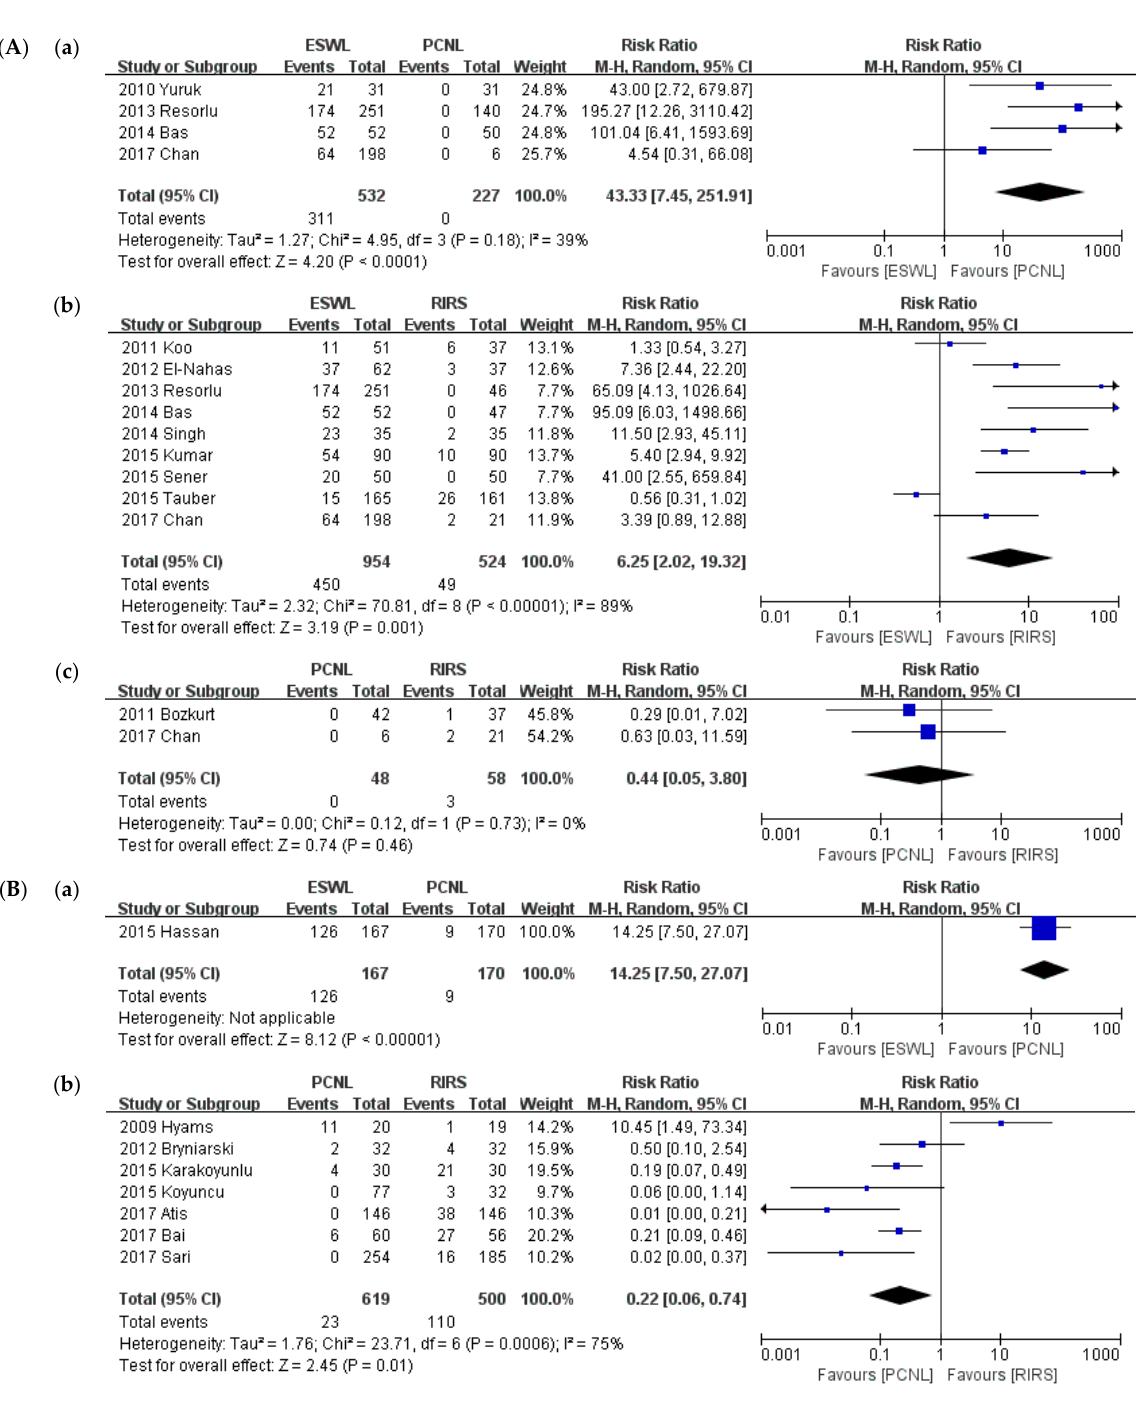
Figure 8. Meta-analysis ( A ). Retreatment procedure (stone size ≤ 2 cm): ( a ) ESWL vs. PCNL; ( b ) ESWL vs. RIRS; and ( c ) PCNL vs. RIRS. Meta-analysis ( B ). Retreatment procedure (stone size > 2 cm): ( a ) ESWL vs. PCNL; and ( b ) PCNL vs. RIRS.